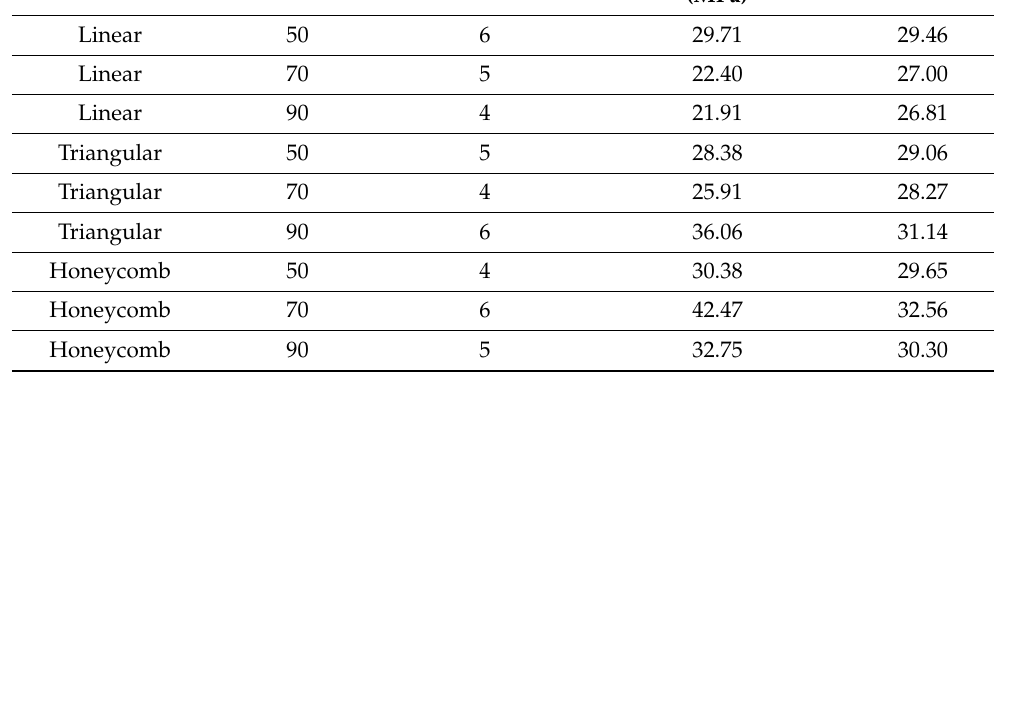
Table 9. SNRA1 values for compressive-tested samples.